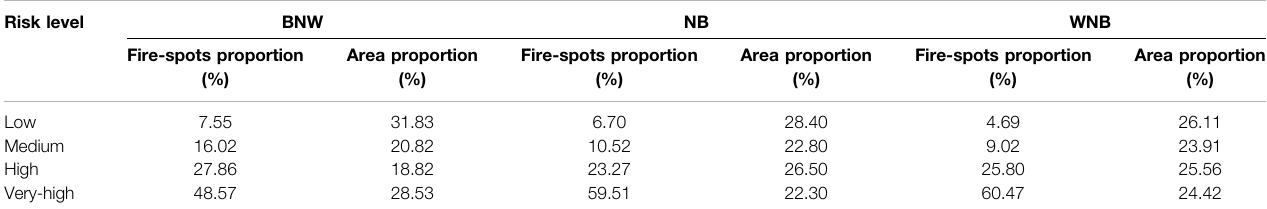
TABLE 3 | The proportions of the grids under the four